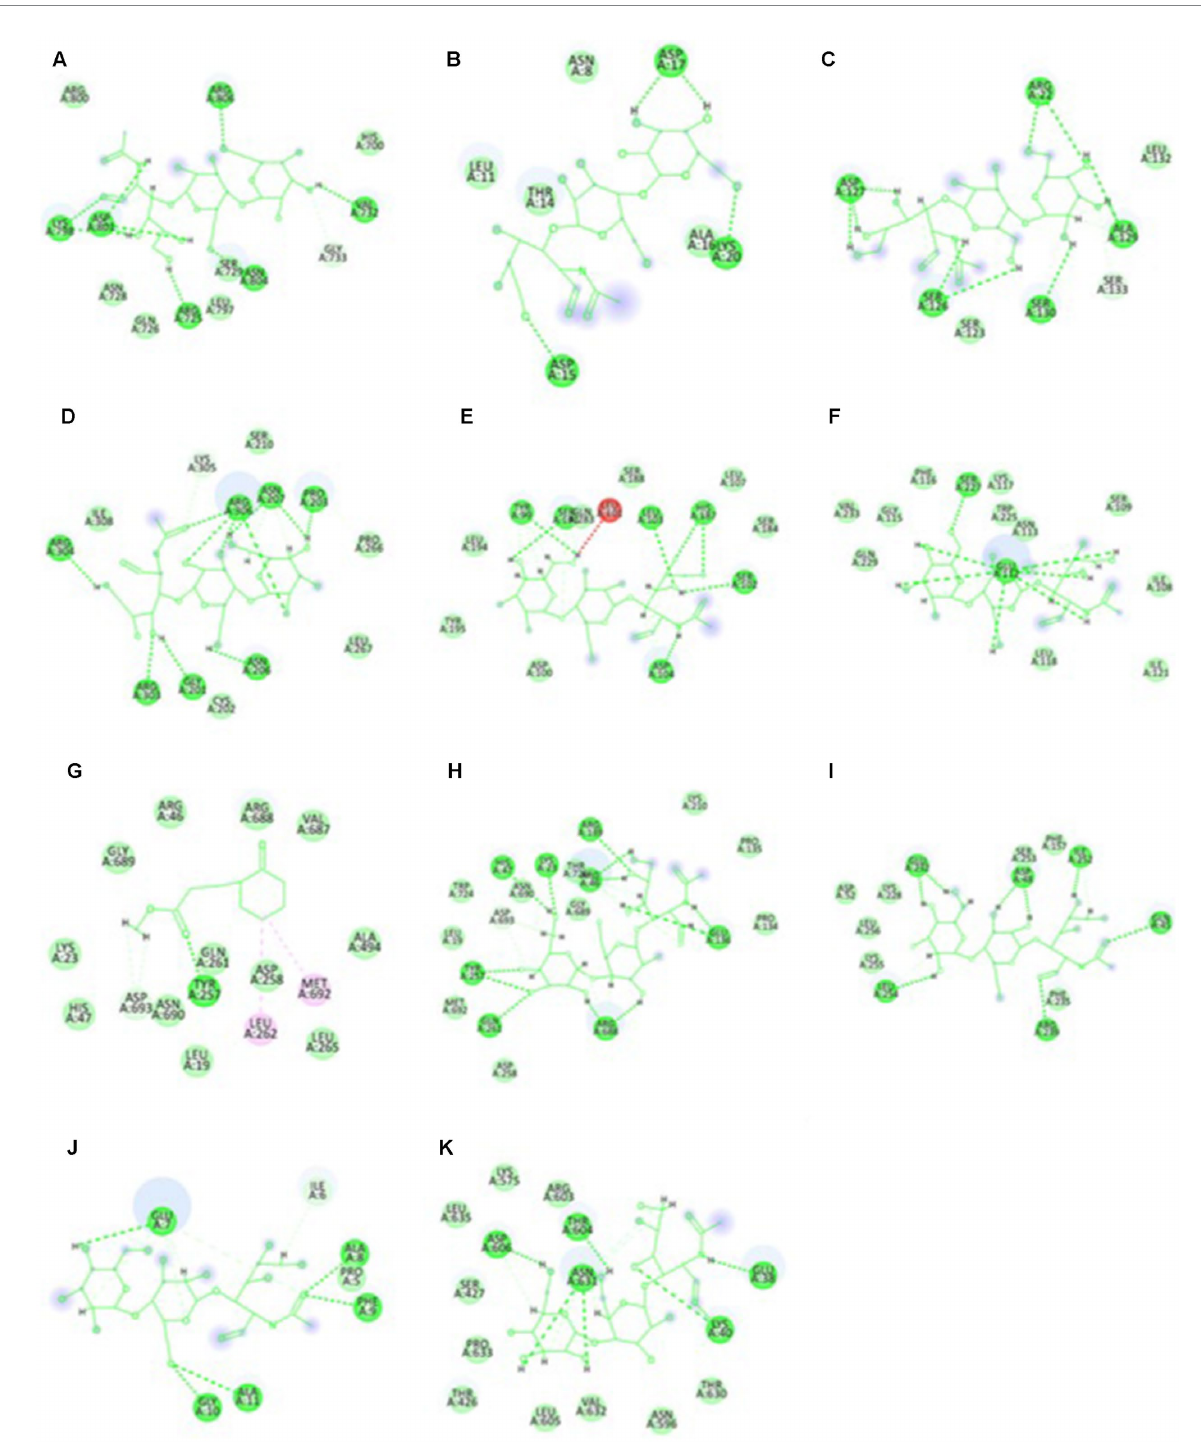
FIGURE 12 The two-dimensional interactional map of 3-o-(4-o-Beta-D-Galactopyranosyl-Beta-D-Galactopyraosyl) 2-Acetylamino-2-Deoxy-D-Galactose against (A) calcium-binding protein, (B) Cellulose synthase, (c) Delta DNA Polymerase, (D) GATA Transcription factor, (E) hypothetical protein, (F) Nucleoside diphosphate kinase, (H) Phenylalanine ammonia lyase, (I) Protein kinase, (J) Ribulose biphosphate carboxylase, (K) SRP, and Cyclohexanepropanoic acid, 2-oxo-, methyl ester (CAS) with (G) Phenylalanine ammonia